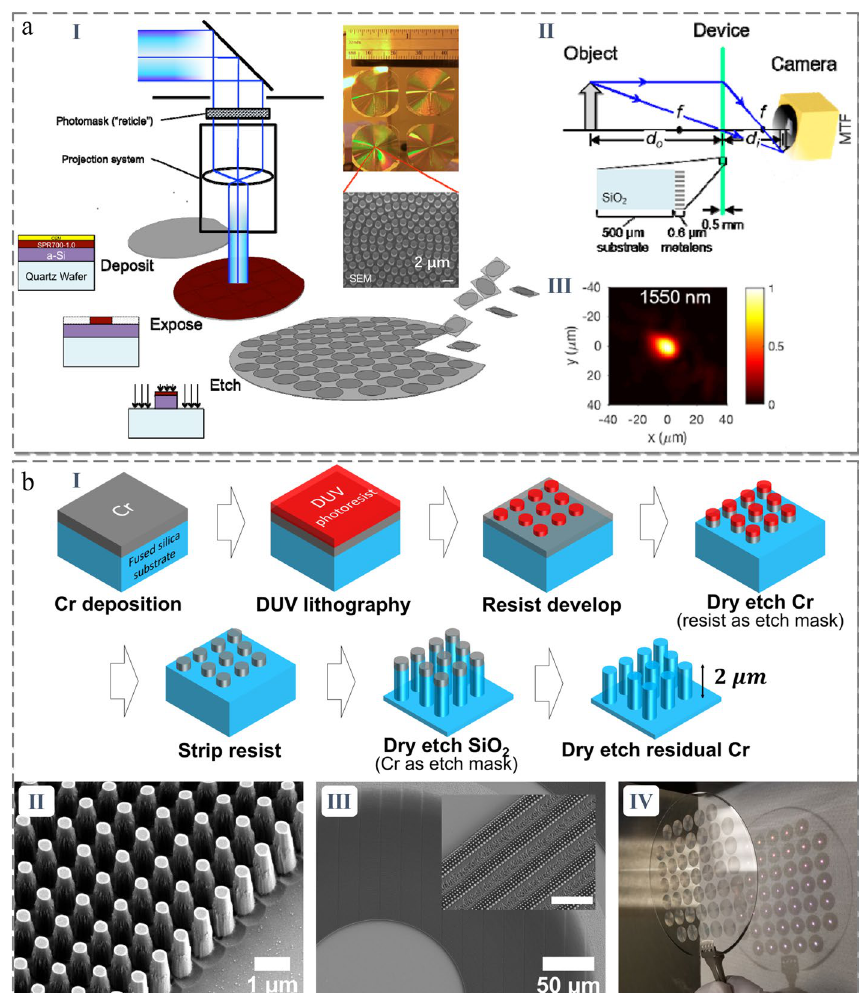
Fig. 12 (a) (I) Schematic showing the production of meta-lenses at low cost and high yield using existing photolithographic stepper technology. The pattern of the meta-lens contained in the reticle was then projected using the stepper, and rapidly replicated over the face of the wafer by repeatedly exposing and incrementally stepping the wafer position. An SEM of the meta-lens center (center right) shows the microscopic posts. (II) The fabricated meta-lens for imaging. (III) Image of focal spot with 7 mm Gaussian illumination at 1550 nm. (b) (I) Fabrication process of the designed meta-lens using the selective etching process. (II) Zoom-in SEM image (tiled) of nanopillars of the meta-lens with a sidewall angle of 2.85°. (III) Top view SEM image near the center, and the inset shows the image of the edge of the lens. (IV) Image of